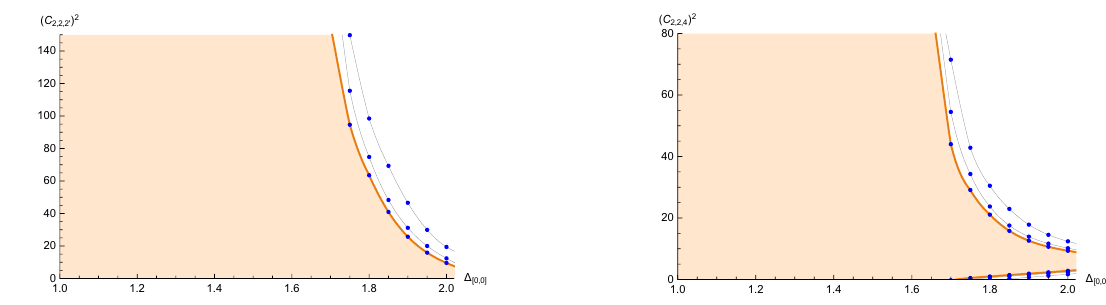
as a function of (cid:1) . We (cid:12)nd [0 ; 0] 2 ; 2 ; 2 0 as a function 2 ; 2 ; 4